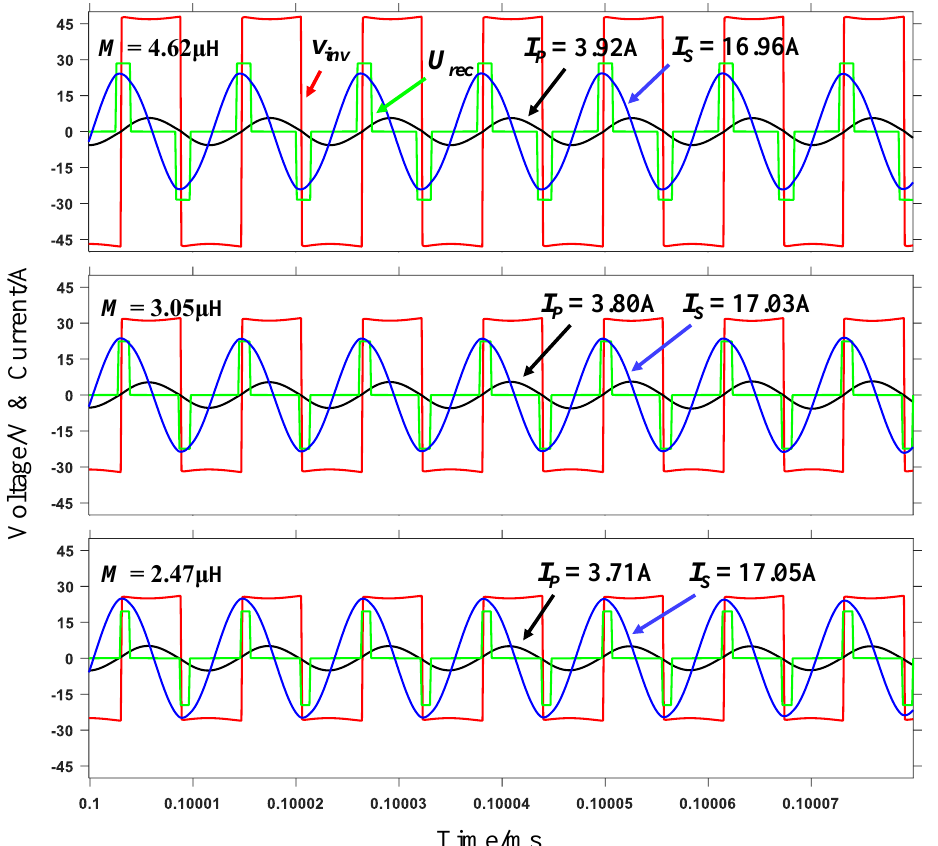
Figure 10. Working waveforms in different offset states.